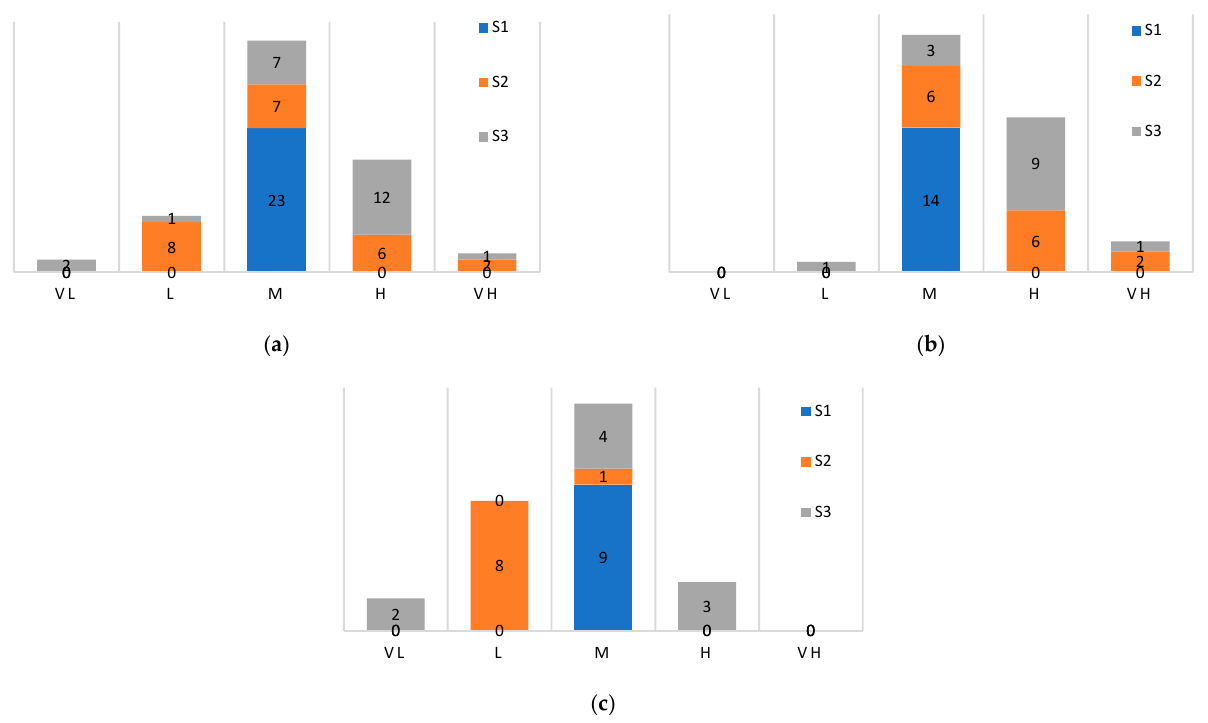
Figure 12. Results of scenario analysis, ( a ) buildings per proposed class, ( b ) academic buildings per class, and ( c ) residential buildings per